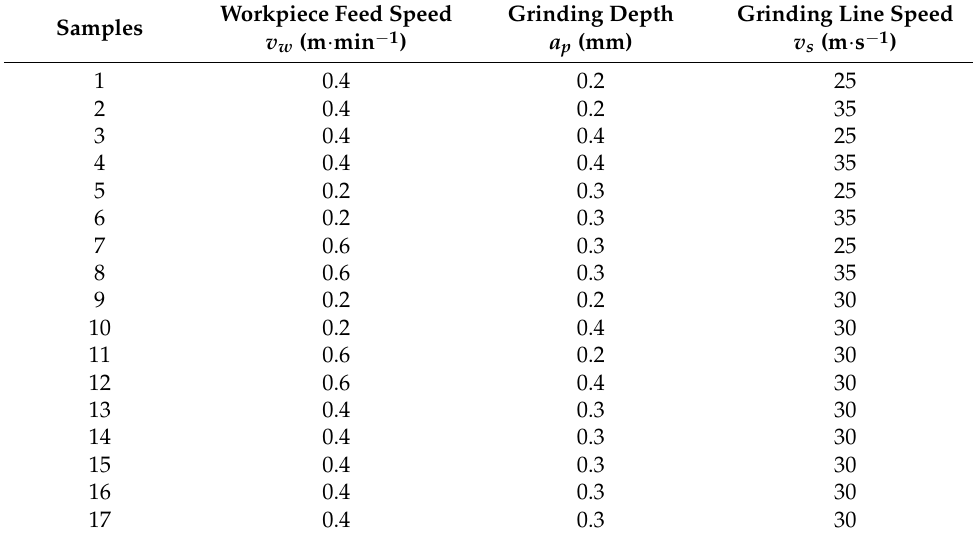
Table 5. Design of experiments with response surfaces.